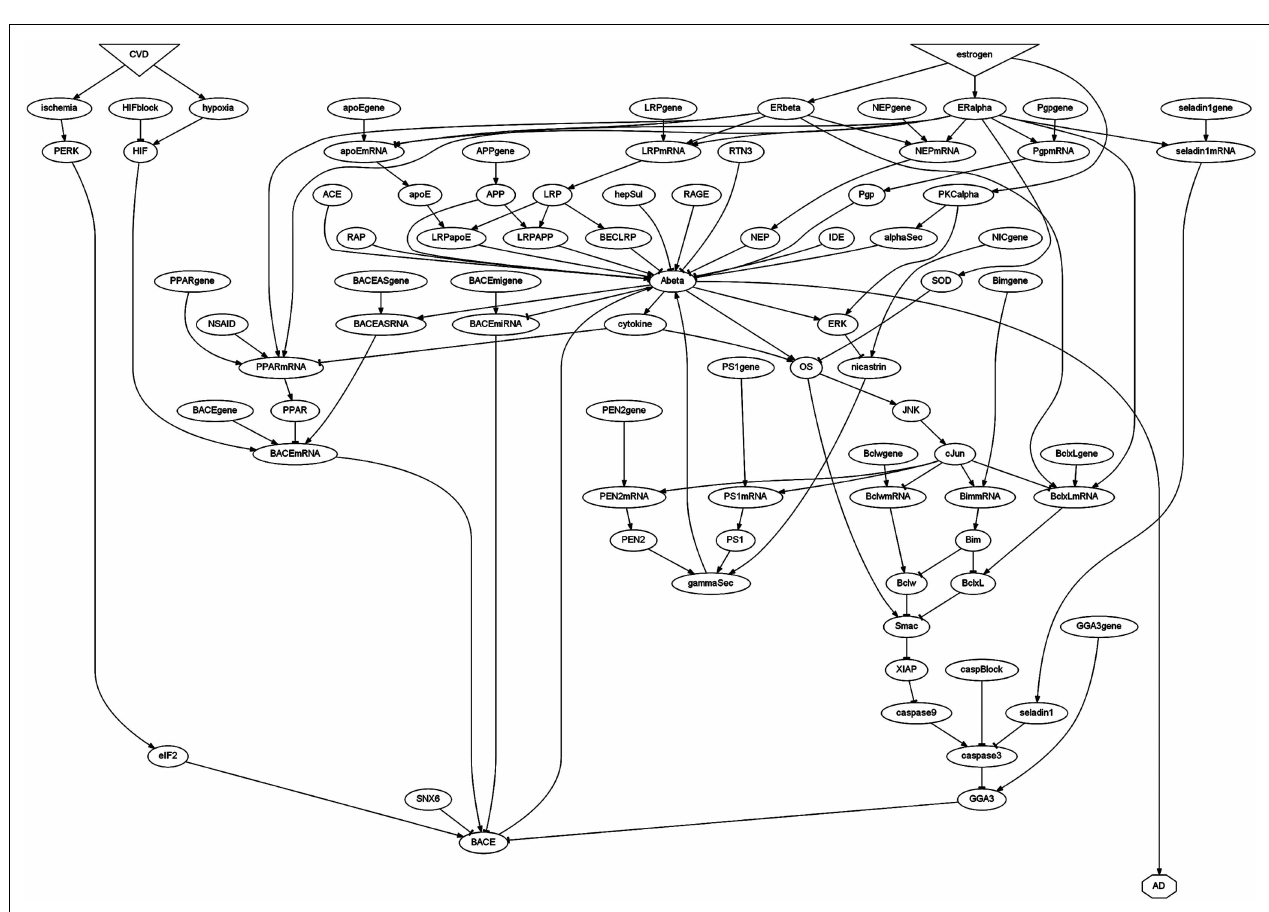
respectively. Estrogen and cerebrovascular disease (CVD) are the main source elements, but any element with no connections leading to it is a source element. Alzheimer Disease (AD), with no connections leading from it, is the only sink element.The other element labels are defined in the